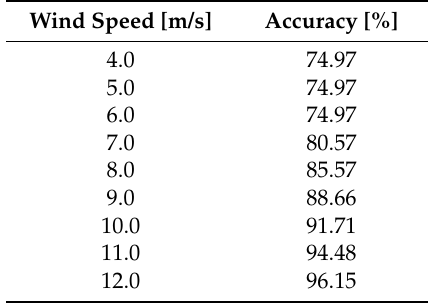
Table A3. The probability that outputs for additional turbine exist within a tolerance band.